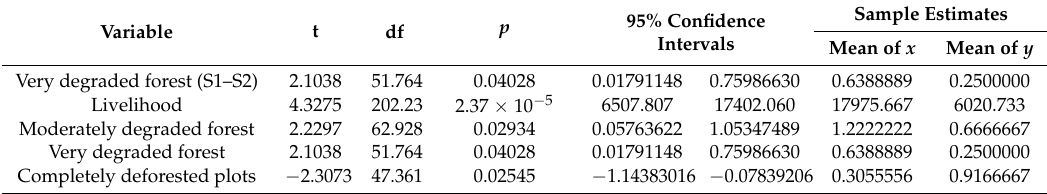
Table A4. Statistical Analysis of Players’ Gaming Behavior and Land-Type Changes. Statistically significant differences between (i) Scenario 1 and 2 for very degraded forest; and (ii) between workshops 1–3 vs. 4–6 for the remaining variables. A Welch two-sample t-test was used with the R software version 3.0.3.